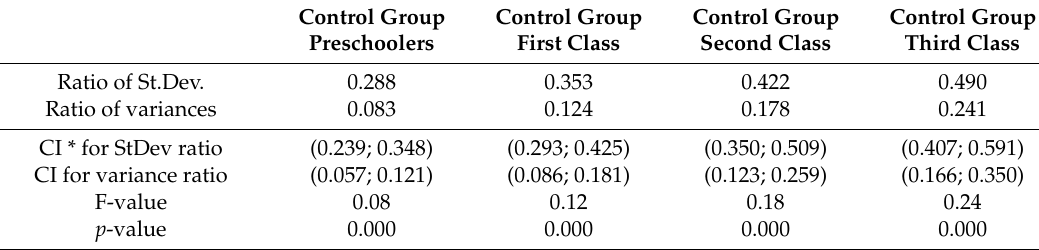
Table 2. Anderson-Darling test results.